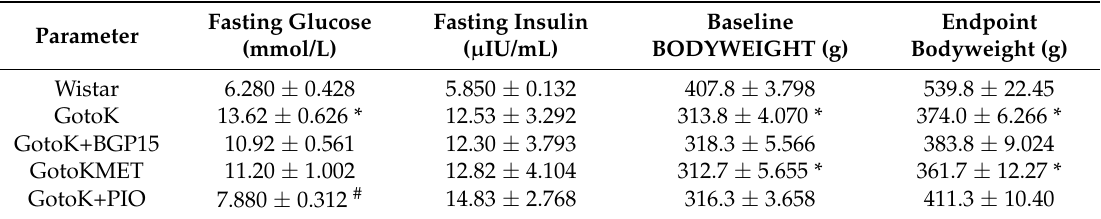
Table 1. Fasting serum glucose, fasting plasma insulin levels, and body weights before (baseline) and after (endpoint) the